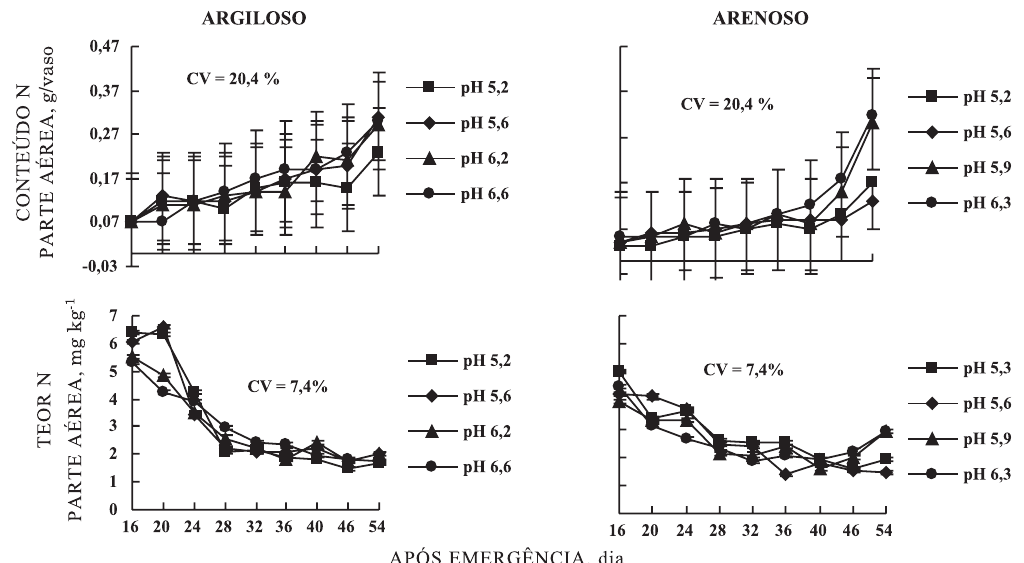
Figura 3. Conteúdo e teor de nitrogênio da matéria seca da parte aérea de plantas de soja, em diferentes épocas de avaliação após a emergência, em relação ao pH inicial do solo argiloso e do